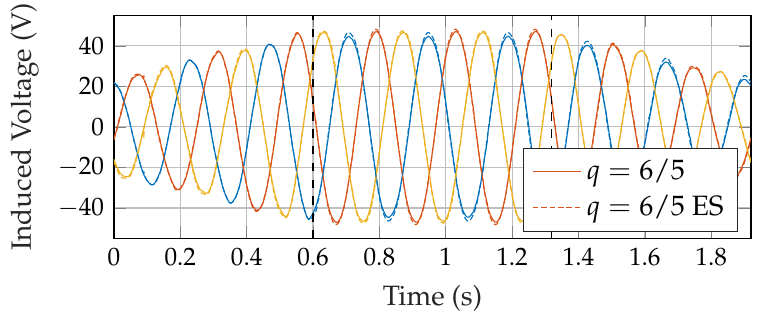
Figure 13. Phase voltages of the buried topology with and without the extended stator (ES). Full active stator area is from t = 0.6 s to t = 1.32 s, indicated by the dashed vertical lines. The different phases are indicated by different colors.